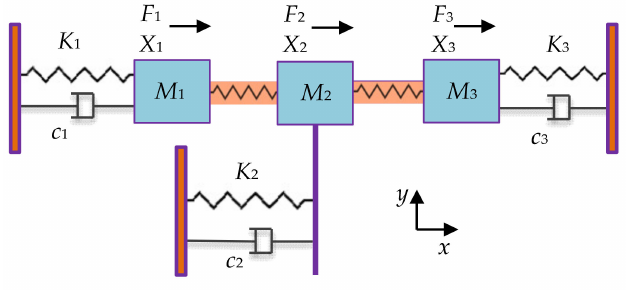
Figure 11. The lumped parameter model of a 3-DoF